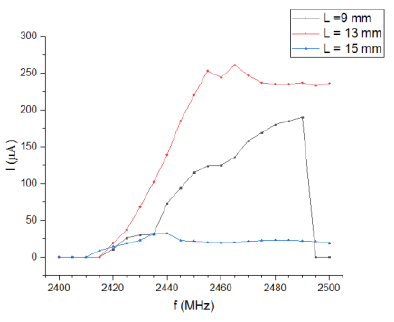
Fig. 4. Dependence of the ion current on the generator frequency for different coupling loops length.